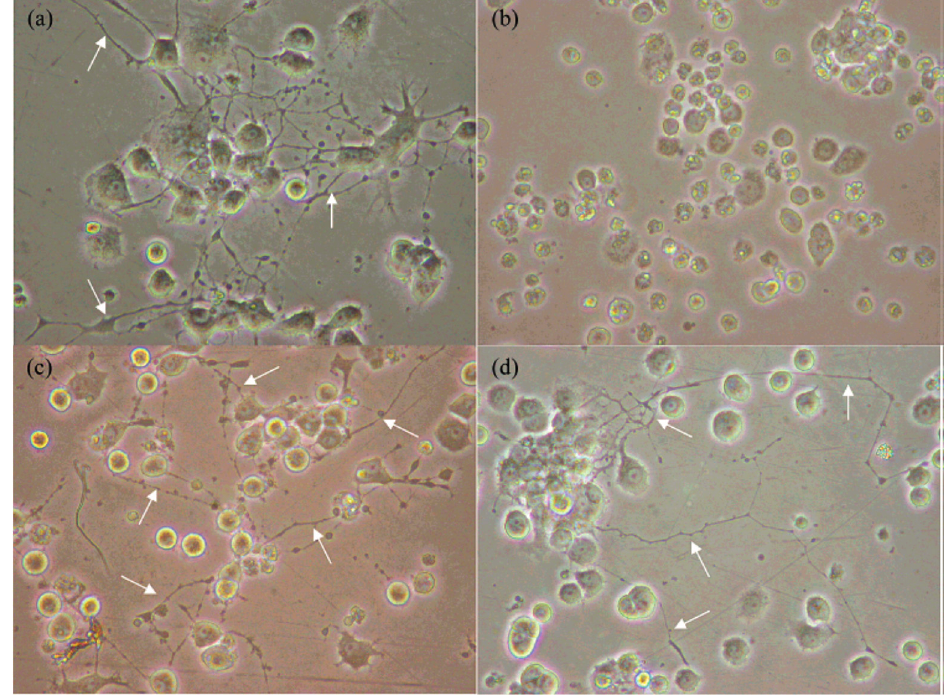
Figure 9. Bioactivity testing of the human β -nerve growth factor (NGF) encapsulated copolymer of ε -caprolactone and ethyl ethylene phosphate (PCLEEP) using PC12 cells. Adapted with permission from [19]. Copyright © 2005 American Chemical